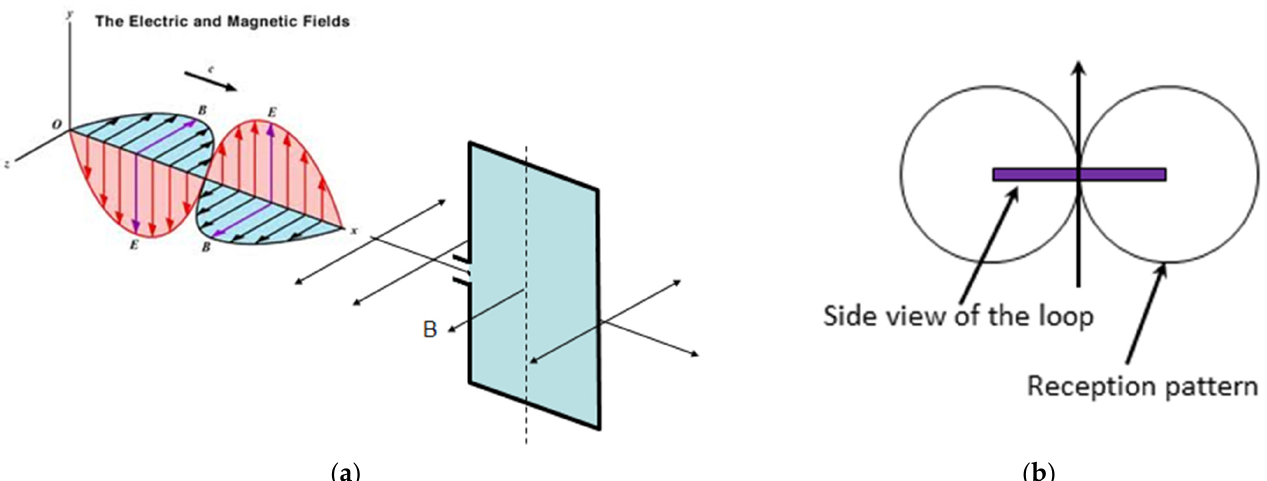
Figure 10. The magnetic loop antenna: ( a ) Best orientation and reception 2D pattern towards the emitted EM wave, and ( b ) reception 3D pattern in space.